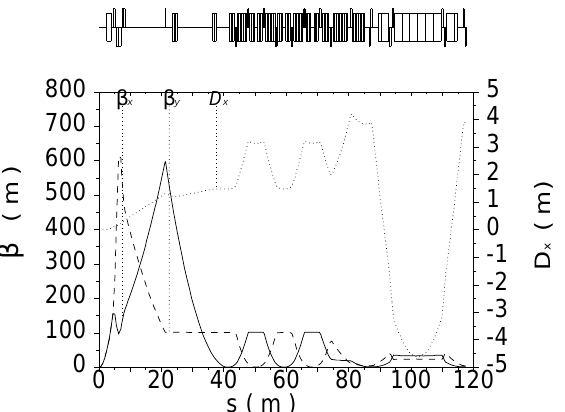
FIG. 43. Example (a): 4 cm b (cid:1) mode showing half of the IR, local chromatic correction section, and one of three arc modules.